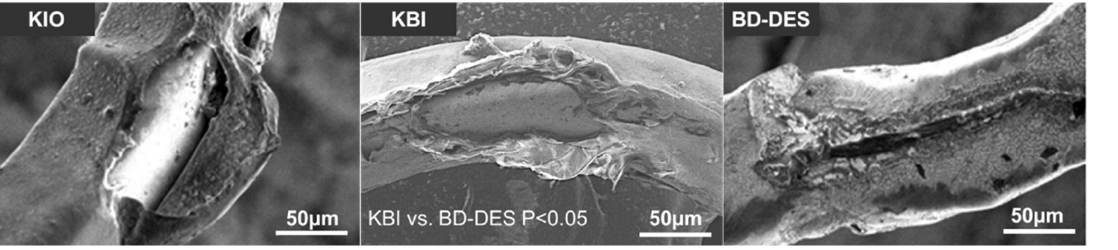
Figure 5. Representative SEM images of drug coating damage. The image was taken at ×500 magnification and scale bar = 50 µm.